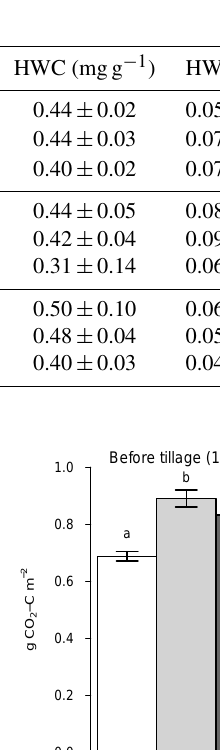
Table 1. Means and standard deviations of soil organic carbon (C), nitrogen (N), C/N ratio, hot-water-extractable carbon (HWC) and nitrogen (HWN) and HWC/HWN ratio before (Pre), after (Post) and 4 days after tillage (Post + 4). Different letters ( a , b ) in each column within treatments (BD, biogas digestate; MF, mineral fertiliser; CL, control) indicate significant differences (Tukey’s HSD test, p < 0.05) in means.